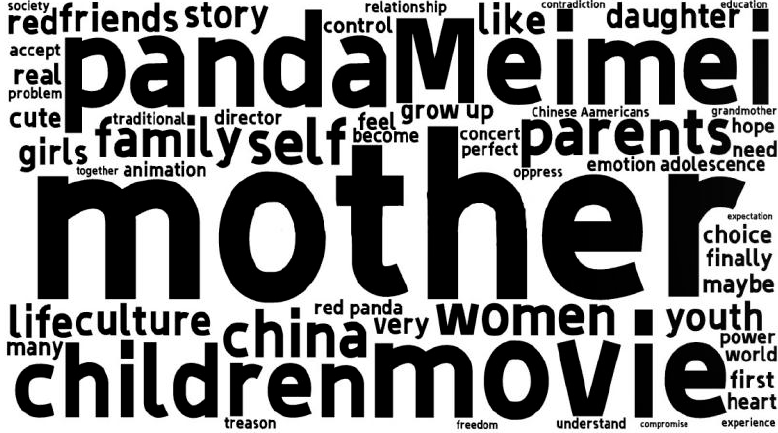
Figure 7. High-frequency word clouds in the film reviews and short reviews of Turning Red on